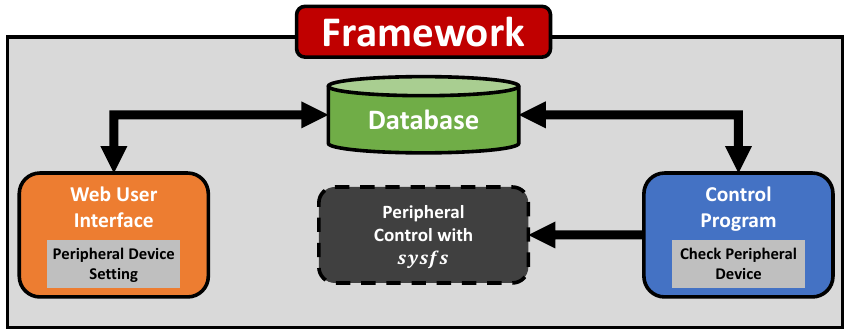
Figure 1. SoEasy